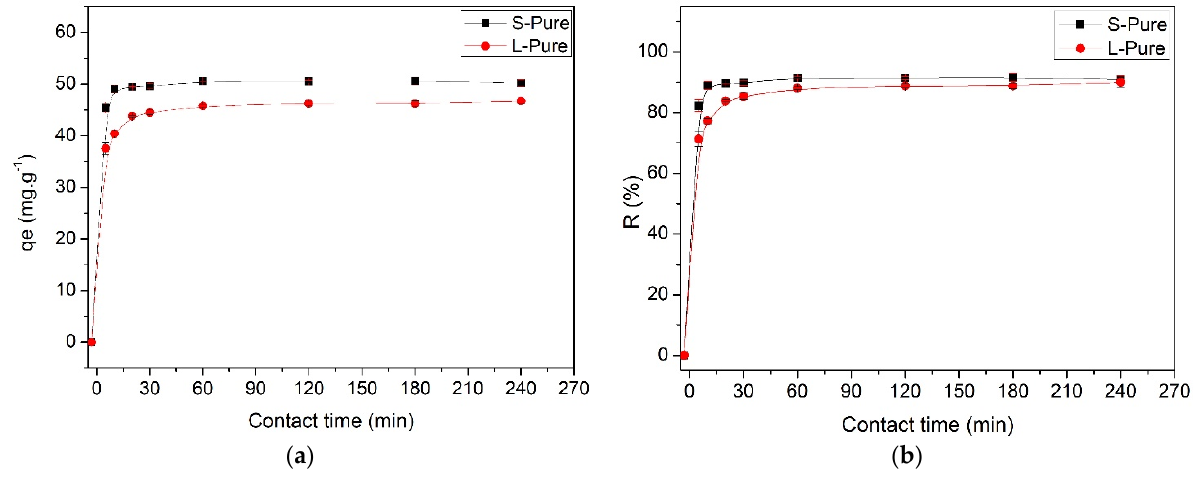
Figure 4. ( a ) Time isotherm for MB removal by water hyacinth stem and leaf biomass and ( b ) adsorption efficiency.